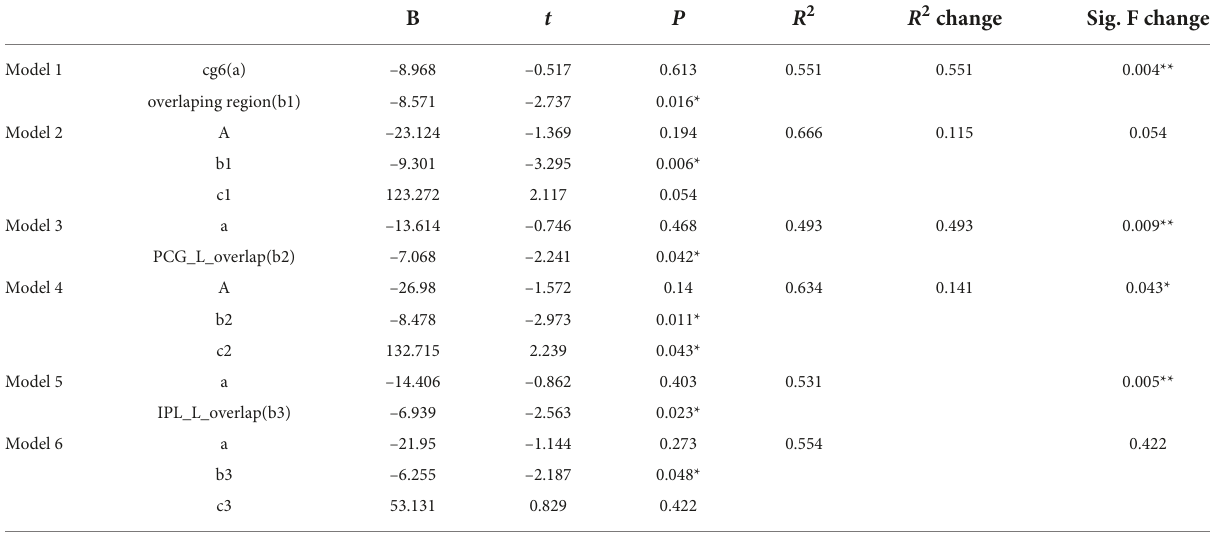
TABLE 4 Linear regression models of brain function and interaction effect with cg1295648 CpG methylation in social function damage in